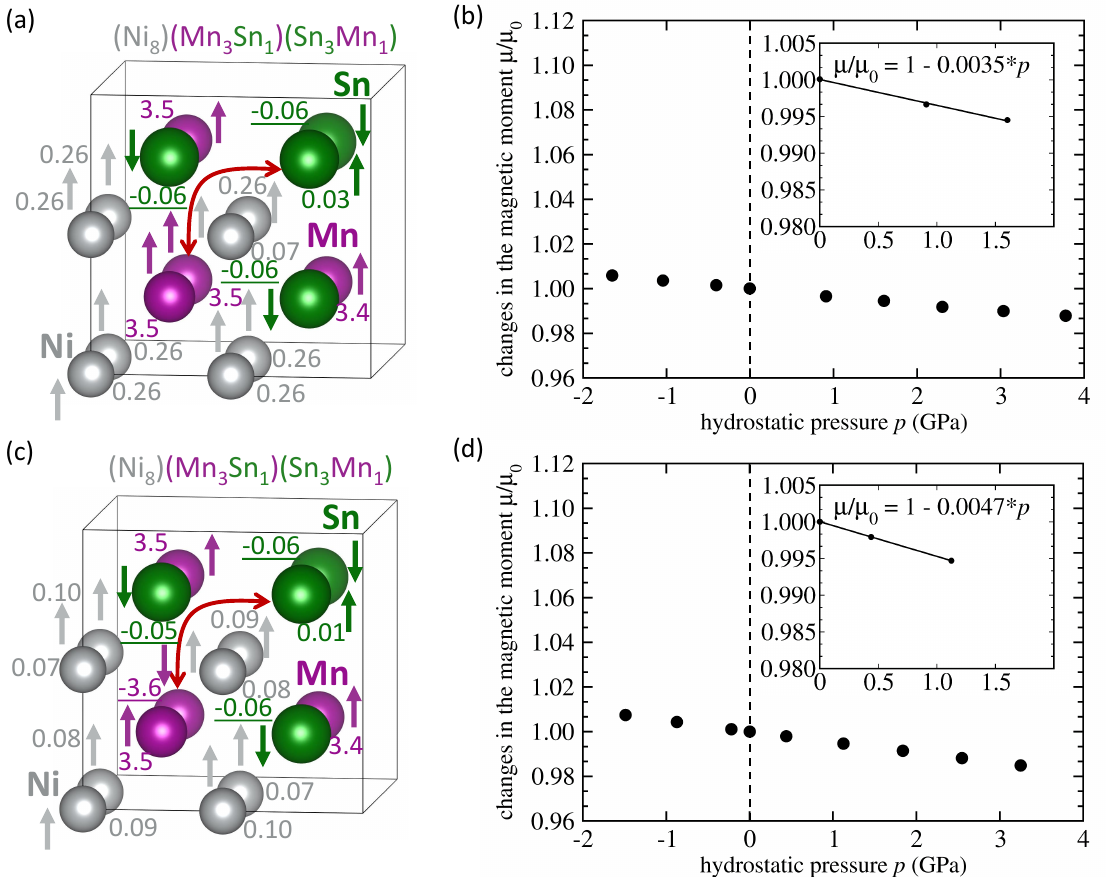
Figure 3. A 16-atom computational supercell of the austenitic stoichiometric Ni 2 MnSn with one Mn atoms swapping one Sn atom as indicated by the red arrow ( a ) with the local magnetic moment of the swapped Mn atom (on the Sn sublattice) having the orientation equal as that of Mn atoms at the Mn sublattice. Included are also values of local magnetic moments (in Bohr magnetons) corresponding to a minimum-energy zero-pressure state. Part ( b ) shows the calculated pressure-induced changes of the total magnetic moment of the state in part ( a ) together with the corresponding linear fit. Figure ( c ) shows a state with the swapped Mn atom having its local magnetic moments anti-parallel to the Mn atoms on the Mn sublattice. Part ( d ) shows calculated pressure-induced changes of the total magnetic moment of the state shown in part ( c ) together with the corresponding linear fit. Magnitudes of local magnetic moments are listed in Bohr magnetons and negative underlined values mean antiparallel